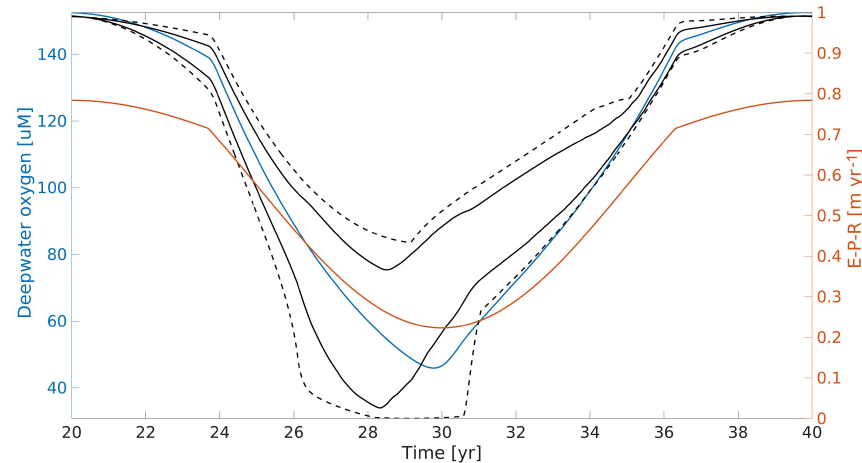
Figure A1. An example of the sensitivity analyses. Here the maximum of R 1 is varied randomly by up to 5 × 10 3 m 3 s − 1 above or below the general setting over 200 runs. The blue line indicates the initial run, the solid black lines indicate the upper and lower 1 σ of each point in time, and the black dashed lines indicate the minimum and